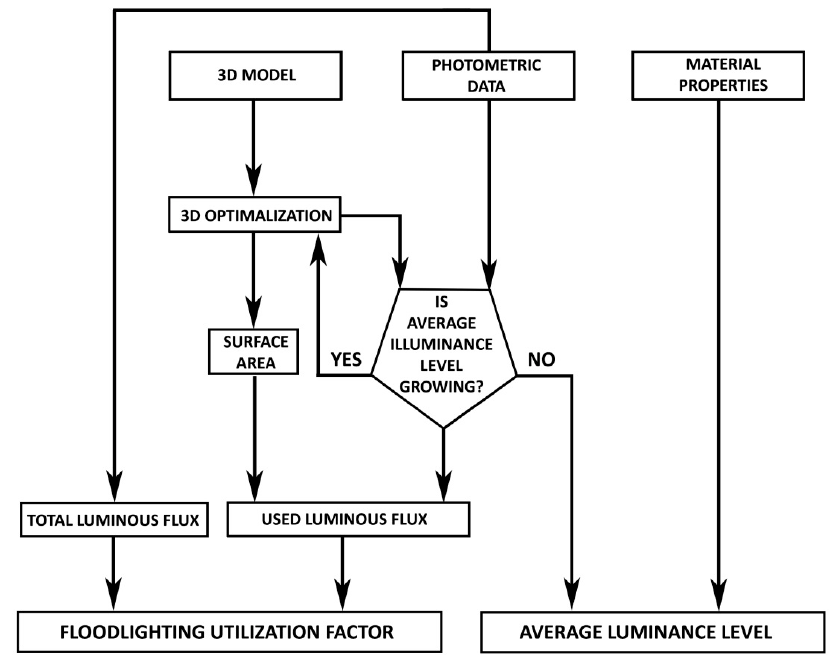
Figure 7. The flowchart scheme of the methodology procedure.